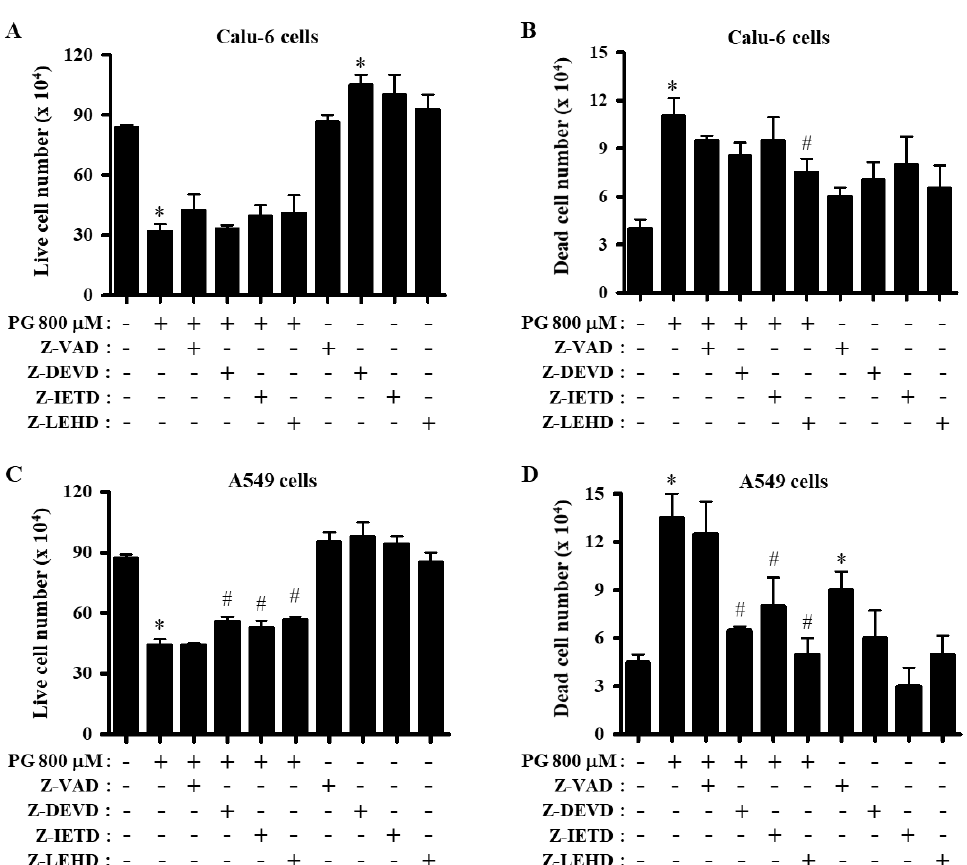
Figure 1. Effect of PG and caspase inhibitors on cell proliferation in Calu-6 and A549 lung cancer cells. Exponentially growing cells were incubated with 800 µ M PG and/or each caspase inhibitor (15 µ M) for 24 h. Live and dead cell numbers were assessed by the trypan blue exclusion cell counting assay. ( A , B ) Graphs show the numbers of Calu-6 live ( A ) and dead cells ( B). ( C , D ) Graphs show the numbers of A549 live ( C ) and dead cells ( D ). * p < 0.05 compared with the PG-untreated control group. # p < 0.05 compared with cells treated with PG only. Data are presented as the mean ± SD. Z-VAD, pan-caspase inhibitor; Z-DEVD, caspase-3 inhibitor; Z-IETD, caspase-8 inhibitor; Z-LEHD, caspase-9 inhibitor.